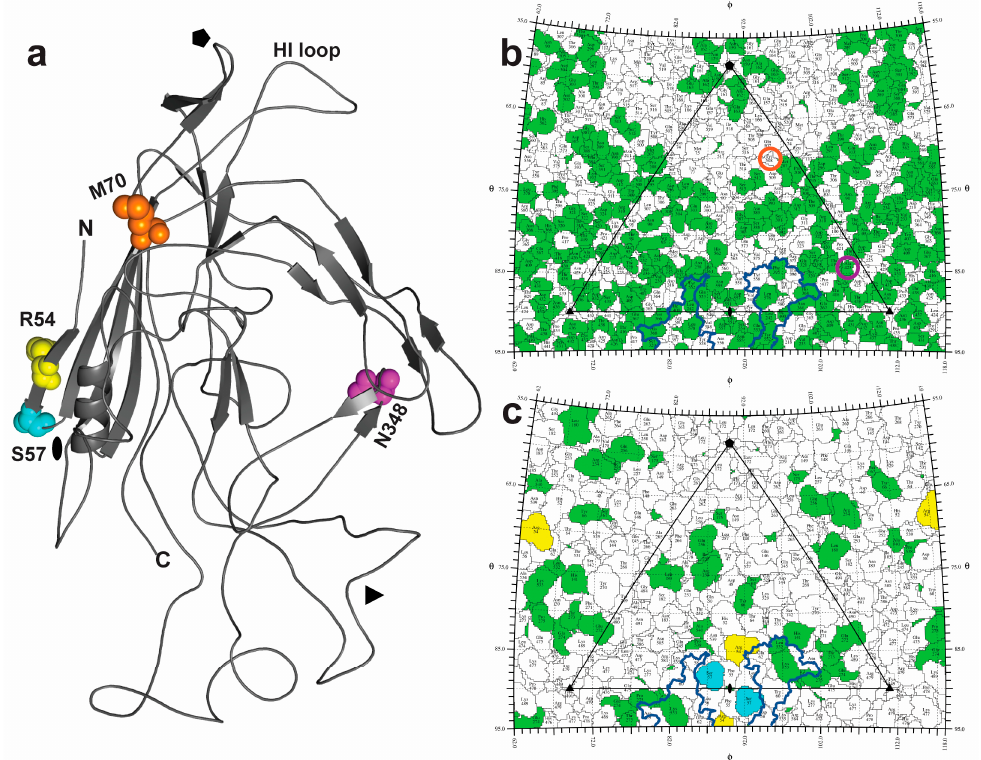
Figure 7. Mapping the melanomatropic determinants of MPV1p5 clone Bv1 VP2 monomer. Panel (a) shows a 3D model of the predicted MPV1p5-BV1 VP2 structure. A VP2 monomer shown in cartoon representation with amino acid residues that differ between MPV1p5-Bv1 and MPV1-Mv1 are labeled, and highlighted as spheres: N348 in magenta, M70 in orange, S57 in cyan, and R54 in yellow. The approximate icosahedral symmetry axes are indicated; 2-fold (oval), 3-fold (triangle), and 5-fold (pentagon). N: N-terminus. C: C-terminus. Panels ( b , c ) show 2D “roadmaps” of the capsid exterior and interior surfaces, respectively. The large triangle delineates the viral asymmetric unit with the icosahedral symmetry axes that are indicated as in ( a ). The previously identified sialic acid binding site for MVMp is mapped onto the MPV1p5-Bv1 capsid, and outlined in navy blue. Residues that differ between MPV1p5-Bv1 and MVMp are colored in green. Bv1 vs Mv1 amino acid differences are colored as in ( a ) for residues N348 and M70 (buried within the capsid, not visible) as well as, S57 and R54 R54, S57 (capsid interior). As identified in ( b ), N348 is located ~20 Å beneath the capsid surface (positioned below residue 423, which is circled in magenta), and M70 is ~9 Å below residue 508, circled in orange.